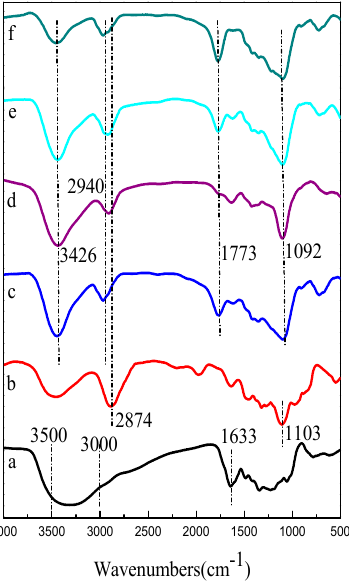
Figure 5. FTIR spectra of TPP ( a ); PEO ( b ); PLA ( c ); and core-shell fibers with the different weight ratios (DCM/DMF) (( d ) 9:1; ( e ) 7:3; ( f ) 5:5) at core solution flow rate of 0.2 mL/h.